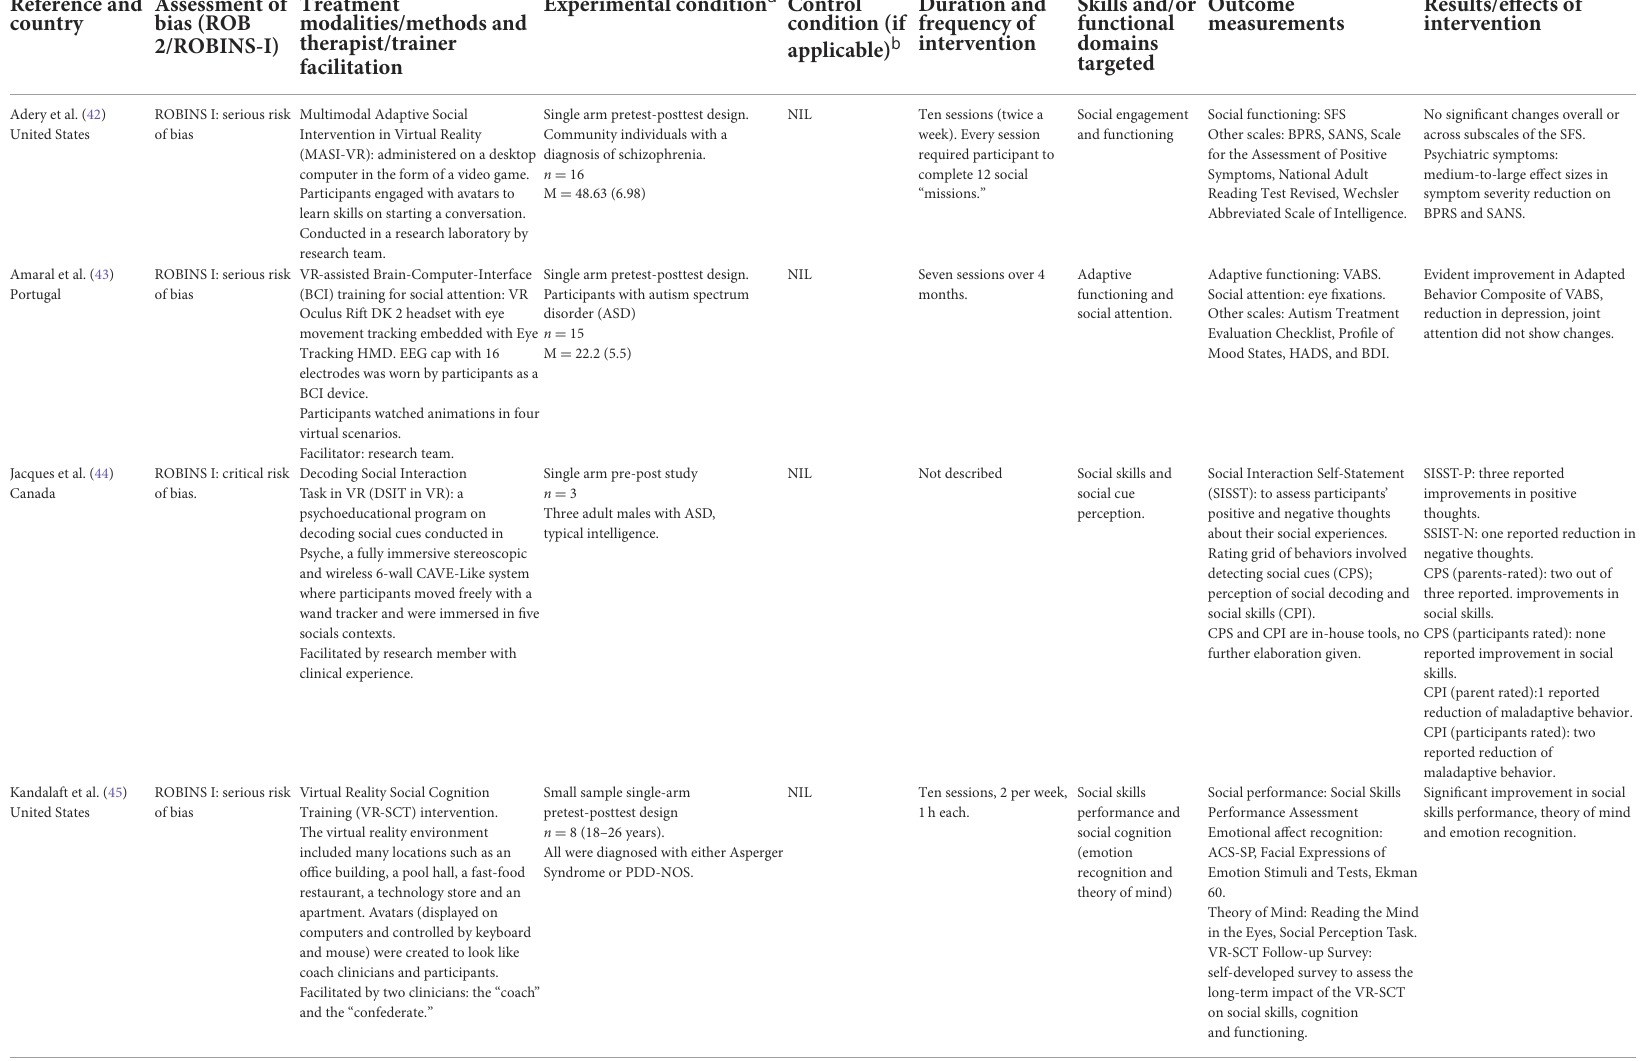
TABLE 3 Studies that addressed social skills and social